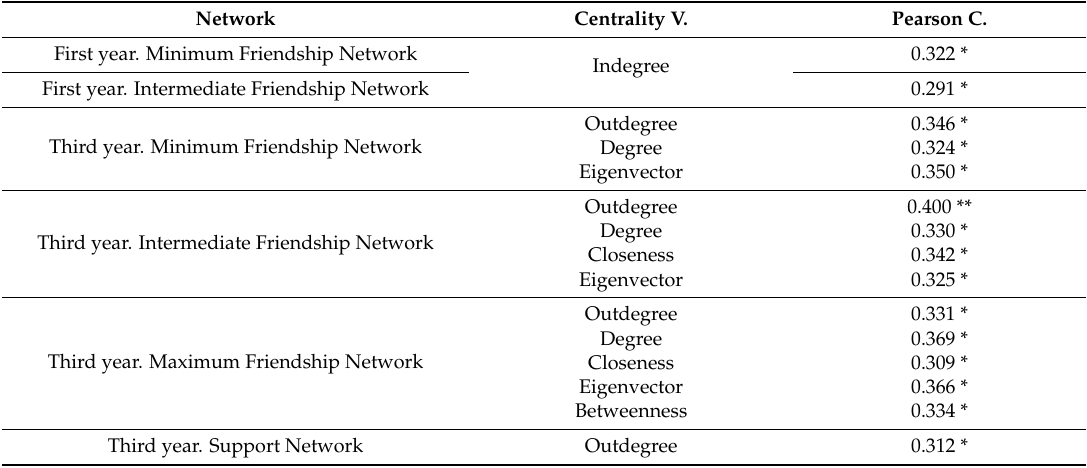
Table 5. Correlations between resilience and centrality